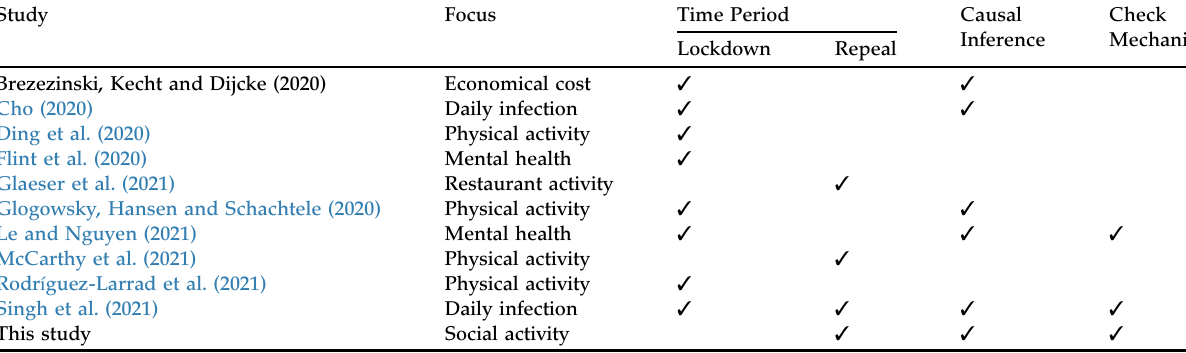
Table 1. Related studies on the COVID-19 lockdown and their research focuses.